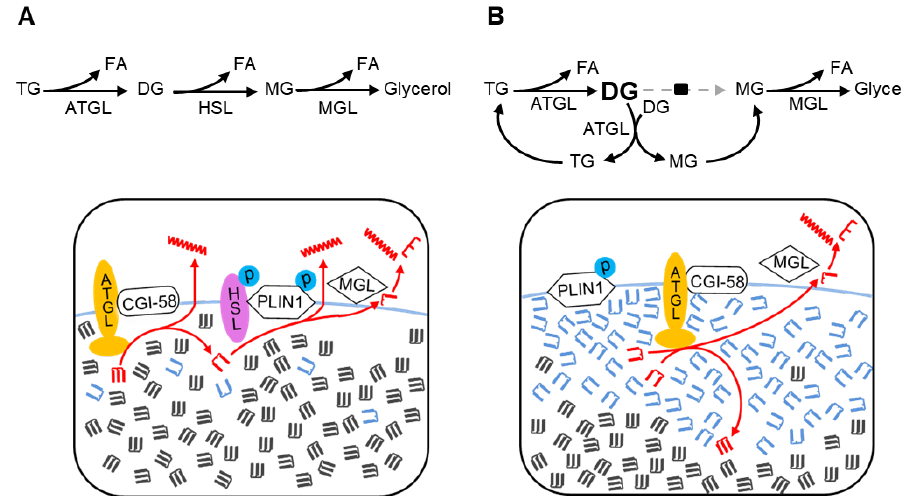
Figure 4. Two pathways of lipolysis. ( A ). The canonical pathway of adipocyte lipolysis. The canonical lipolytic pathway is shown on top and is diagrammed in red below. The first step is TG hydrolysis by ATGL. Next, active phosphorylated HSL on the lipid droplet surface cleaves DGs, maintaining a low level of DGs at the lipid droplet surface. ATGL has transacylation capacity but, under conditions of low DG concentrations, this accounts for a negligible fraction of acylglycerol flux. Monoglycerols are cleaved by MGL. ( B ) The transacylation pathway of adipocyte lipolysis in fasting HSL-deficient WAT. In this pathway, ATGL catalyzes both TG hydrolysis and transacylation of DGs. ATGL-mediated TG hydrolysis in HSL-deficient adipocytes results in high levels of DGs. DGs are less hydrophobic than TGs and hence concentrate at the lipid droplet surface, near ATGL. From two DG molecules, transacylation produces one MG (a substrate for MGL) and one TG that can be cleaved by the lipase activity of ATGL. In HSL deficiency, the high local concentration of DGs is predicted to enhance transacylation by ATGL, which mediates a major fraction of TG turnover and acylglycerol flux under these conditions. DGs are shown in blue; TGs, in dark grey. We considered whether TG might arise in other enzyme-mediated or non-enzymatic chemical reactions. Most TG synthesis in adipose tissue is mediated by DGAT enzymes [40,42], which require acyl-CoA and ATP as substrates and which are bound to the membrane of the endoplasmic reticulum. Under the experimental conditions described in this article, endogenous sources of the soluble substrates of DGAT were removed during gradient centrifugation and ER fragments were also eliminated by the subcellular fractionation used to enrich for lipid droplets. Therefore, the observed TG transacylation from DGs is not attributable to a contamination with DGAT.